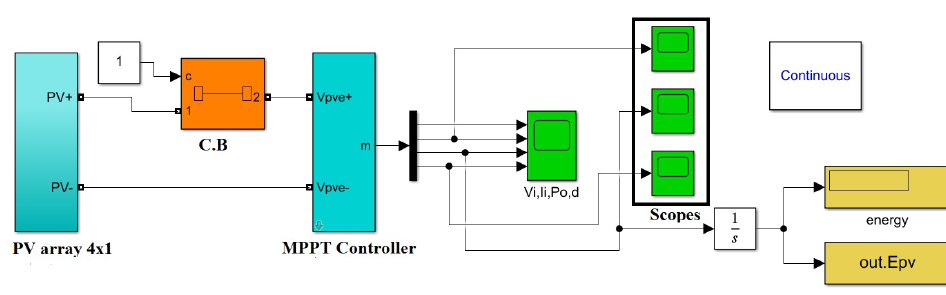
Figure 10. Complete Simulink model of centralized PV